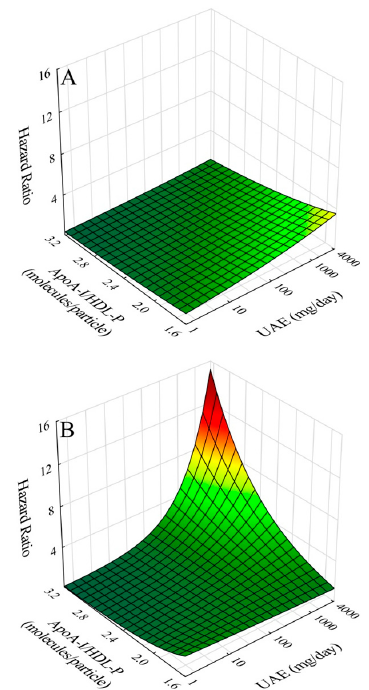
Figure 2. Hazard ratio for cardiovascular disease risk as a function of urinary albumin excretion (UAE) and mean HDL apoA-I content (ApoA-I/HDL-P) given as the number of apoA-I molecules per HDL particle over all HDL particles: ( A ) without inclusion of interaction of UAE and apoA-I content; and ( B ) with inclusion of interaction of UAE and apoA-I content.